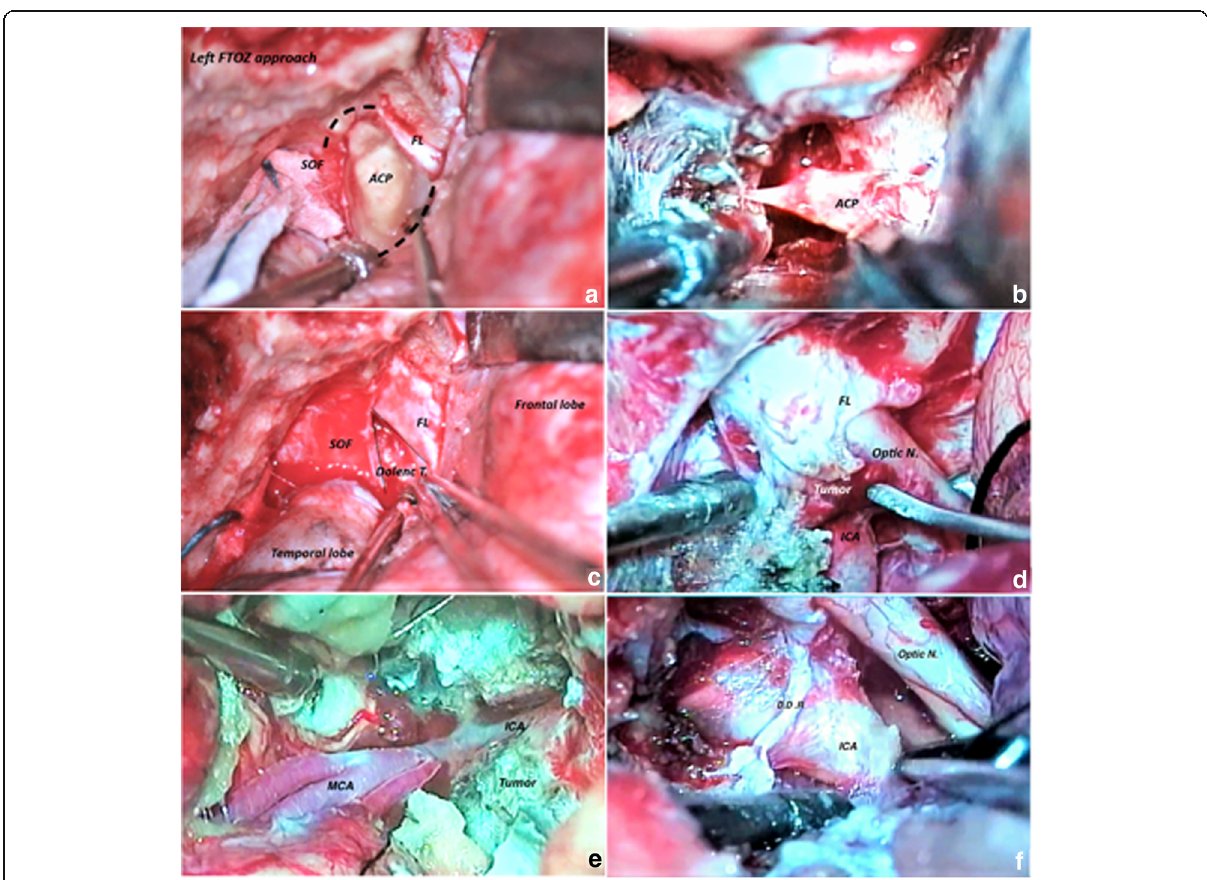
Fig. 1 a – f Sequential intraoperative view of the left ACM resection through a left FTOZ approach. a Extradural bone drilling of the sphenoid ridge, the posterior orbital roof, and the optic canal roof exposing the ACP between the superior orbital fissure ( SOF ) and the falciform ligament ( FL ) covering the optic nerve. b Removal of the ACP tip (shark tooth). c The optic strut is drilled out exposing the Dolenc triangle ( Dolenc T. ). d The tumor was extending in the optic canal beyond the falciform ligament; optic nerve decompression was done by releasing the falciform ligament and tumor debulking with care not to compromise any vascular supply to the undersurface of the optic nerve. e , f Encasement of the internal carotid artery ( ICA ) and middle cerebral artery ( MCA ) by the tumor, careful dissection of the tumor aided by mobilization of the ICA through releasing the distal dural ring ( DDR